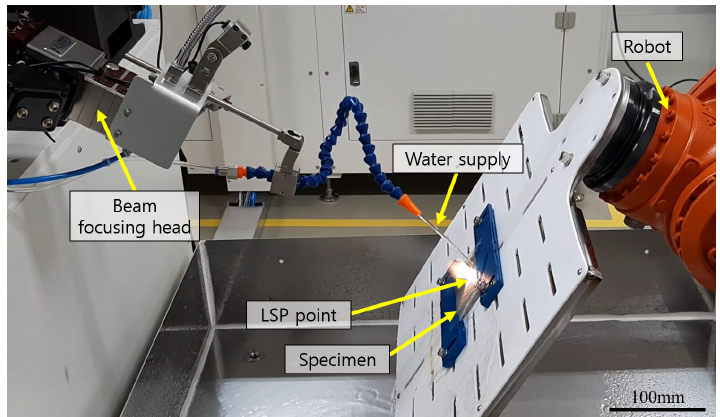
Figure 4. LSP experiment system